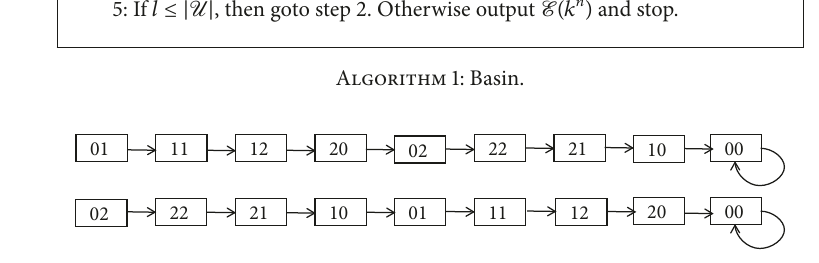
Figure 5: State diagram of NFSR1 in Example 22.